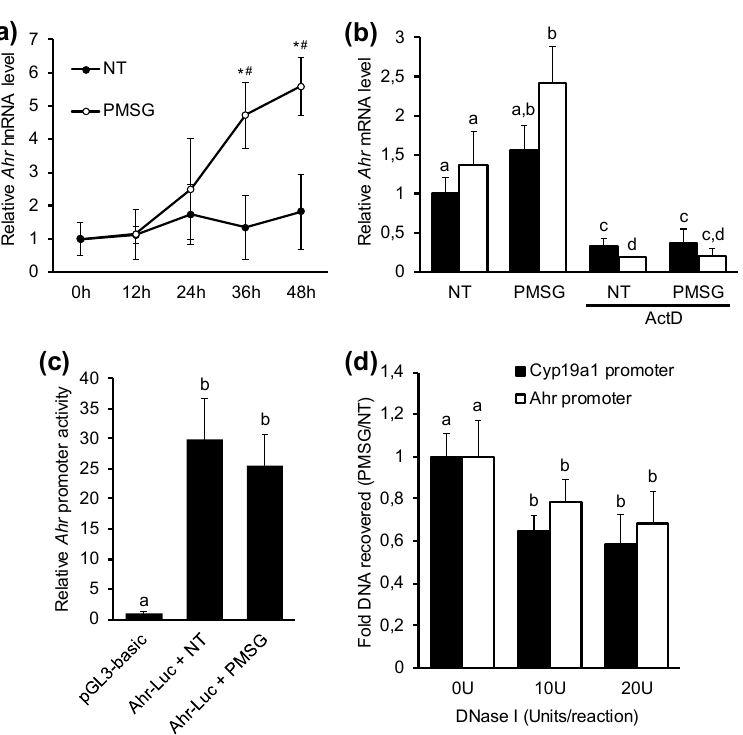
Figure 5. The effect of pregnant mare’s serum gonadotropin (PMSG) on Ahr gene expression mechanisms. ( a ) Ahr heteronuclear RNA (hnRNA) levels were measured by qPCR in GCs isolated before (0 h) or up to 48 h after PMSG (5 IU) or vehicle (NT) treatment in vivo. Data are presented as means ± SD from five independent experiments. * p < 0.05 vs NT; # p < 0.05 vs. 0 h. ( b ) Mice were injected with 5 IU of PMSG, GCs were isolated 48 h later and cultured in vitro. Following attachment (2–3 h later), cells were incubated with vehicle (NT) or PMSG (5 IU/mL) alone or in combination with transcription inhibitor actinomycin D (ActD, 1 μ g/mL). Ahr mRNA levels were measured 2 h and 4 h later by qPCR. Data are presented as means ± SD from three independent experiments. ( c ) GCs isolated from immature mice were cultured in vitro, transfected with empty vector (pGL3-basic) or Ahr -luciferase reporter constructs and treated with vehicle (NT) or PMSG (5 IU/mL) for 48 h followed by analysis of luciferase activity. Data are presented as means ± SD from three independent experiments. ( d ) Mice were injected with 5 IU of PMSG or vehicle (NT) and GCs were isolated 48 h later. DNA from nuclei treated with increasing concentrations of DNase I was analyzed by qPCR. The recovered DNA at promoter sites of interest were normalized to recovered genomic DNA from Pax7 promoter, the data are presented as ratio of PMSG vs. NT from five independent experiments (mean ± SD). Bars with no common superscripts are significantly different ( p < 0.05).